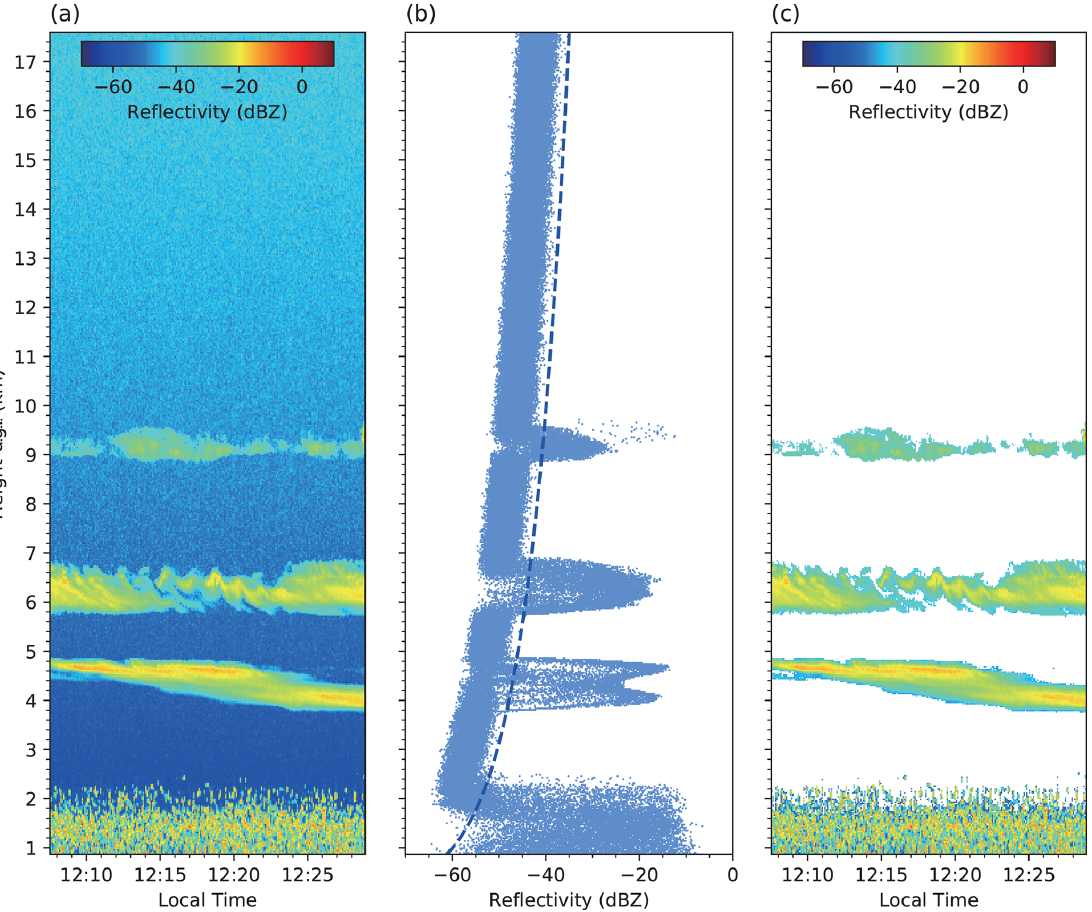
Figure 2. (a) Raw reflectivity and (c) noise-removed reflectivity from 12:08 to 12:29LT on 28 May 2014. (b) The 300 reflectivity profiles of the same duration; the dashed blue line is noise-equivalent reflectivity